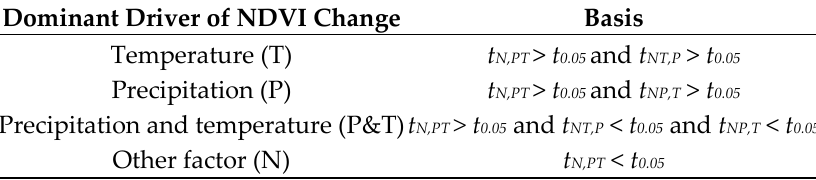
Table 1. The basis of regionalization for the dominant drivers of NDVI change in northern China ( t NT,P is the test statistic of the partial correlation coefficients between NDVI and temperature, excluding the influence of precipitation on NDVI; t NP,T is the test statistic of the partial correlation coefficients between NDVI and precipitation, excluding the influence of temperature on NDVI; t N,PT is the test statistic of multiple correlation coefficients between NDVI, precipitation, and temperature; t 0.05 is the critical value of the test statistic at a 0.05 significance